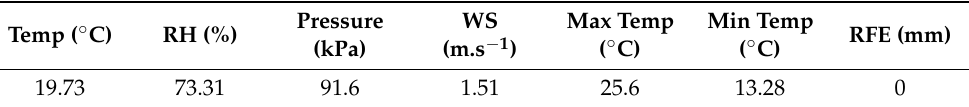
Table 1. Climatic data of the region on 10 December 2018. City of Santo Ant ô nio do Amparo, MG,